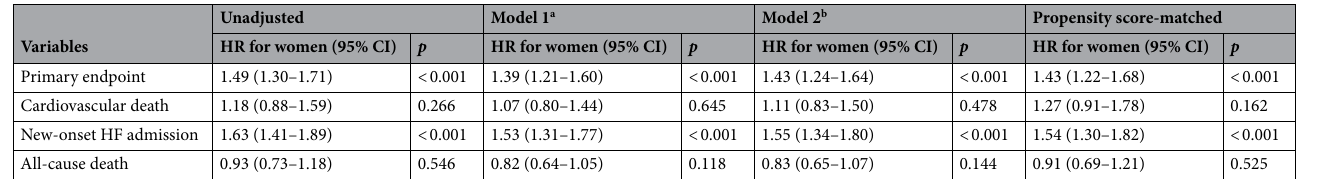
Table 3. Sex differences in the multivariable Cox regression analysis in the original and the propensity score- matched cohorts of patients with HCM. HCM hypertrophic cardiomyopathy, HR hazard ratio, HF heart failure. age, Charlson comorbidity index, low income, hypertension, dyslipidemia, ischemic heart disease requiring coronary intervention, chronic kidney disease, atrial fibrillation, and beta-blocker.